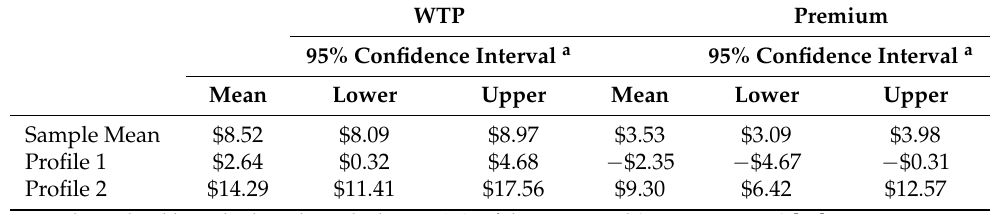
Table 3. Estimated WTP for 25% Biochar Potting Mix and Premium Compared with Conventional Biochar. WTP Premium 95% Confidence Interval a 95% Confidence Interval